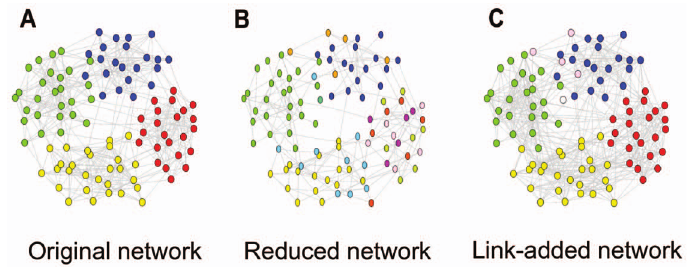
Figure 2. Triangle completion aggregates shattered modules. Original network with 4 communities in A, removing links leads to small shattered communities in B, and completing triangles in the shattered network integrates small communities in